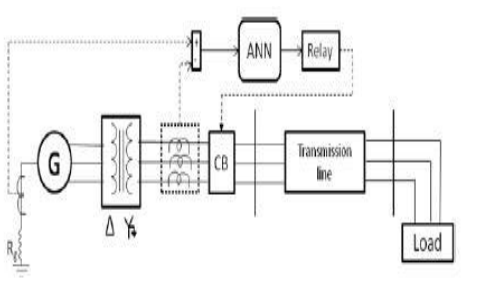
Figure 3 . structure of the proposed ANN based differential protection